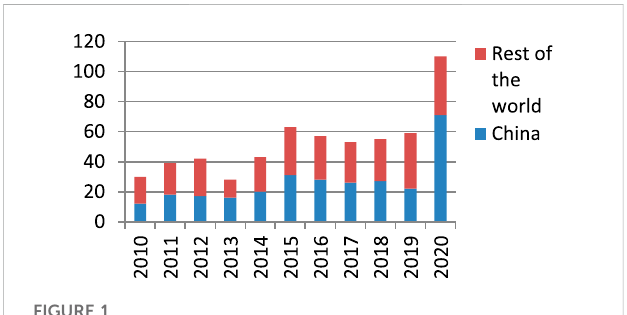
FIGURE 1 Wind capacity (Annual change, GW). Source: BP statistical reviews of world energy (2021).